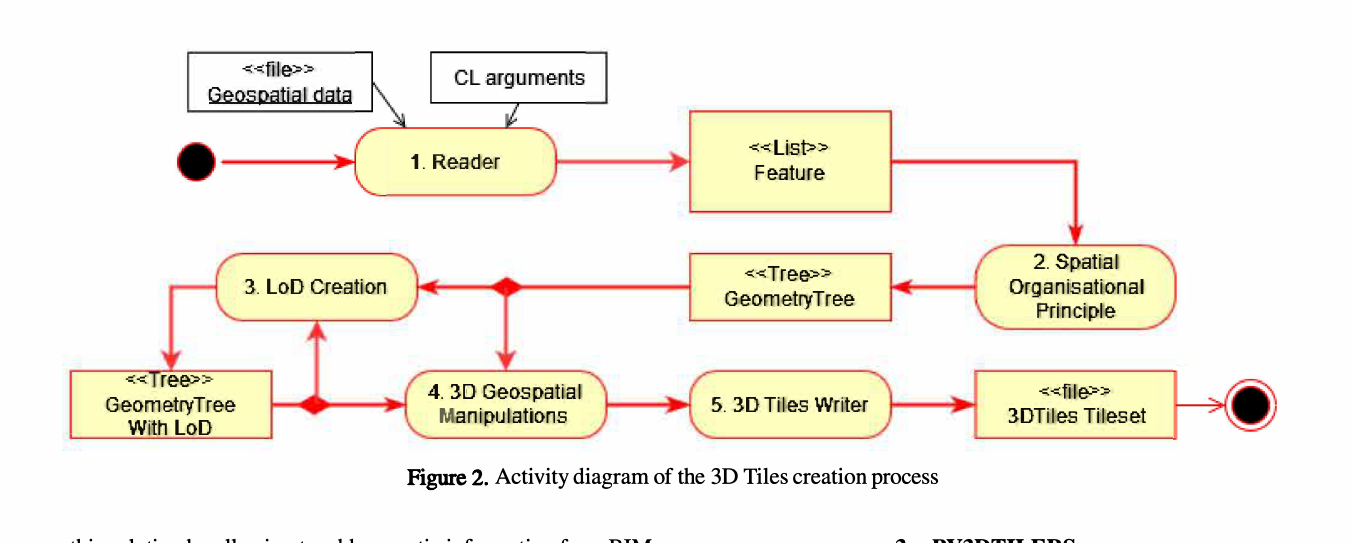
Figure 2. Activity diagram of the 3D Tiles creation